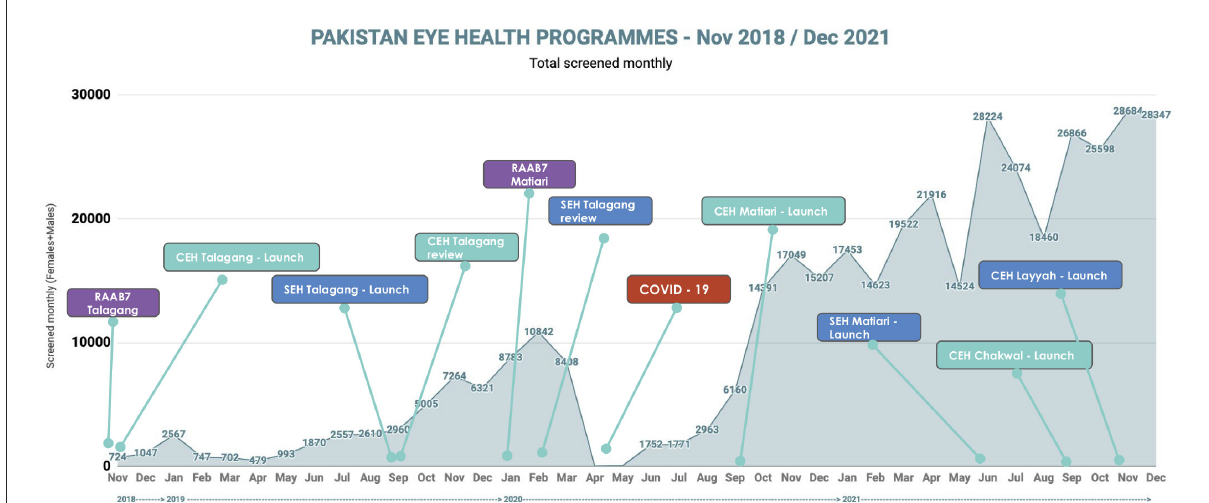
FIGURE2 Screening volume, from programme initiation in November 2018 to December 2021. CEH, Community Eye Health; SEH, School Eye Health; RAAB7, Rapid Assessment of Avoidable Blindness, version 7 The chronological order of programme activities including RAAB surveys for evaluation of baseline prevalence of visual impairment, the launch of community and school eye health programmes, and iteration reviews for evaluation and monitoring of programmes are shown over time. Additionally, the number of people screened per month in all programmes is represented (blue